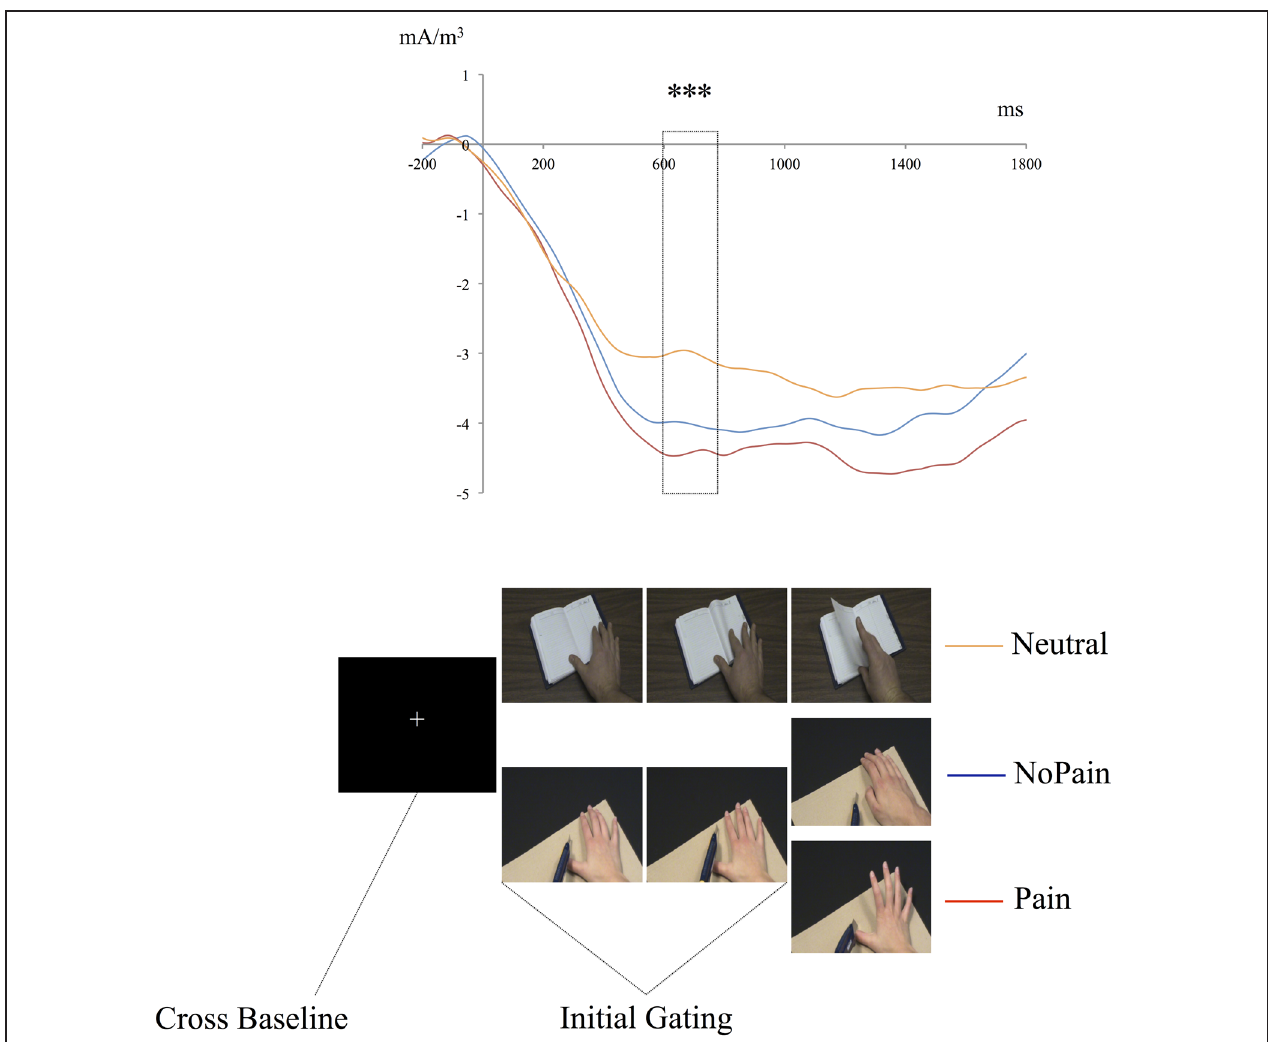
FIGURE 4 | Time course of the mean energy (mA/m 3 ) of the somatosensory steady-state response (SSSR) during the presentation of the pseudo-dynamic stimuli. The mean energy of the somatosensory gating (SG) during the first two pictures [initial gating (600:800 ms)] was